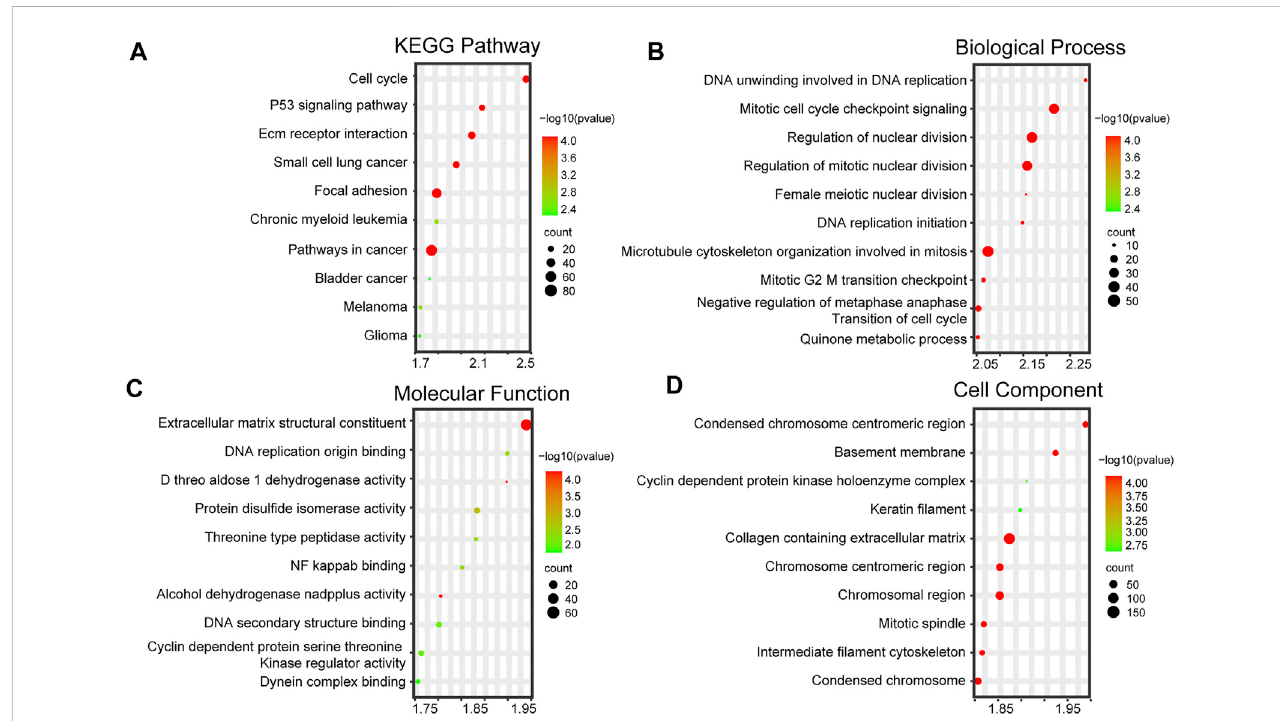
FIGURE 6 Functional enrichment analysis of PBC with differential AKR1B10 levels. High and low AKR1B10 groups are based on the median of AKR1B10 expression levels. (A) Top 10 KEGG pathways of the AKR1B10 high-expression group. Top 10 enriched GO terms, including BPs (B) , MFs (C), and CCs (D) , of the